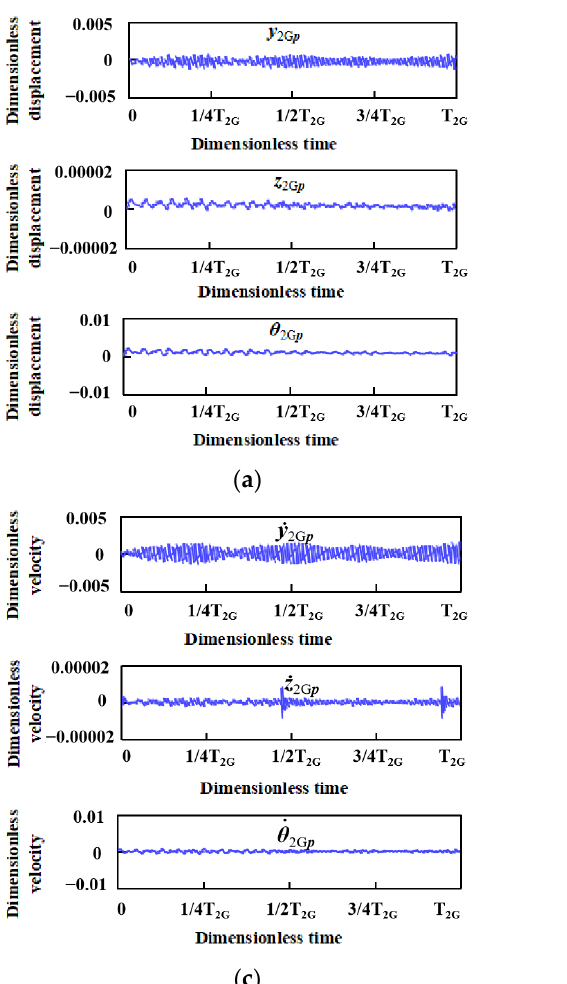
Figure 8. State space of the first-stage gear pair Z 1 and Z 2 : ( a ) vibration displacement of driving gear; ( b ) vibration displacement of driven gear; ( c ) vibration velocity of driving gear; ( d ) vibration veloc- ity of driven gear.